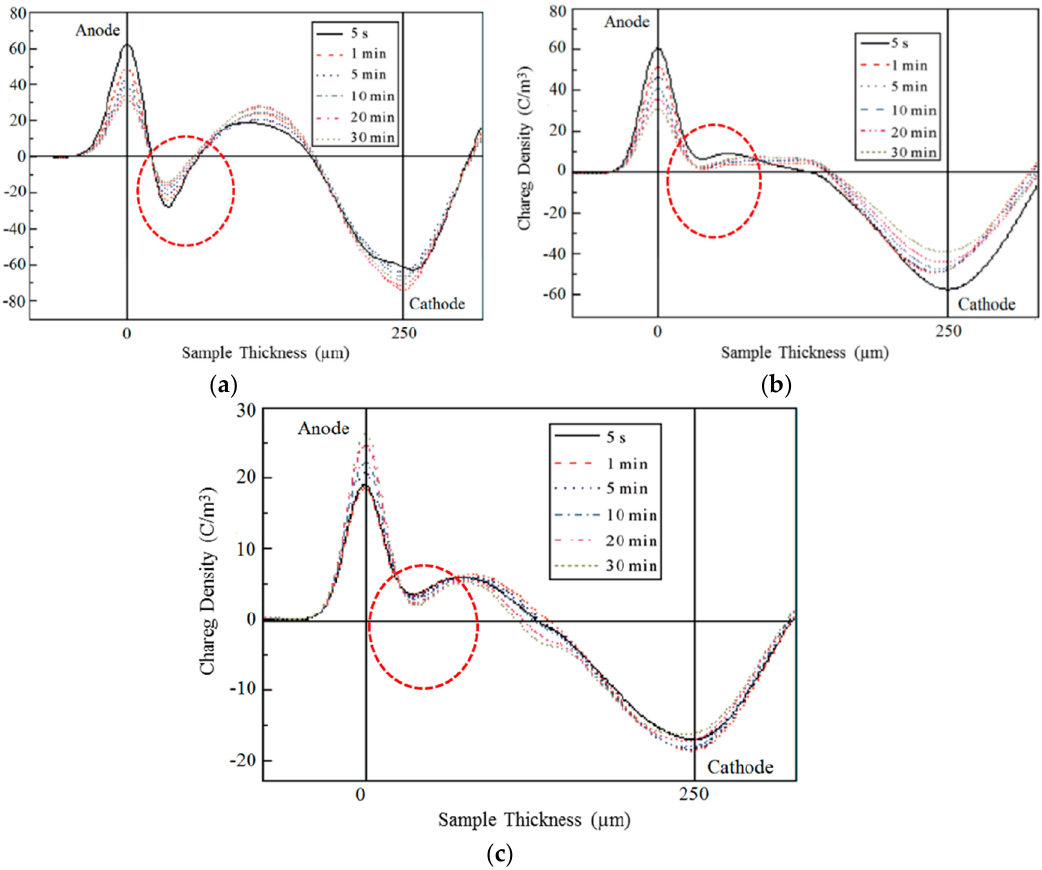
Figure 34. Space charge distribution of samples P0 ( a ), P1 ( b ) and P2 ( c ) under 30 kV/mm applied electric field [58].